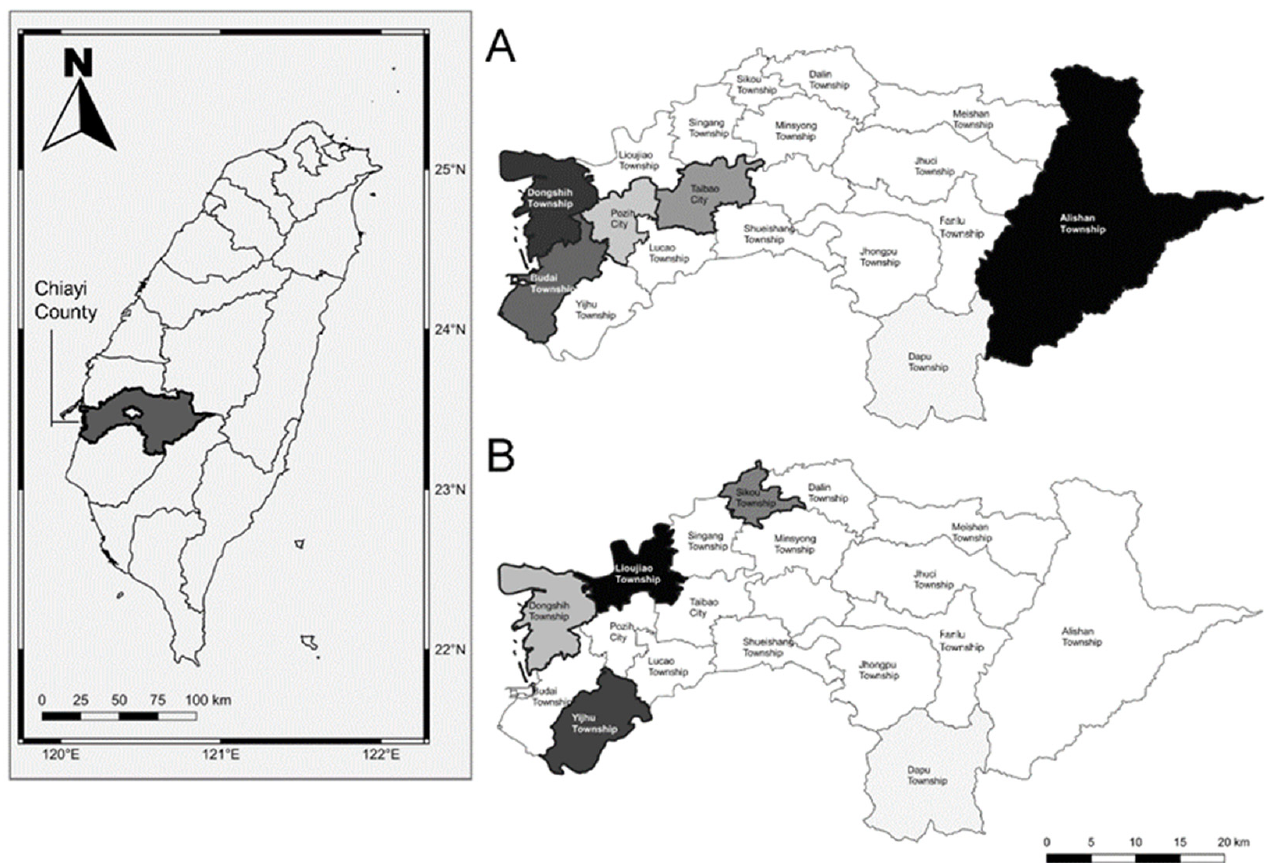
Figure 1. Location of the study county and endemic townships of ( A ) hepatitis B and ( B ) hepatitis C.